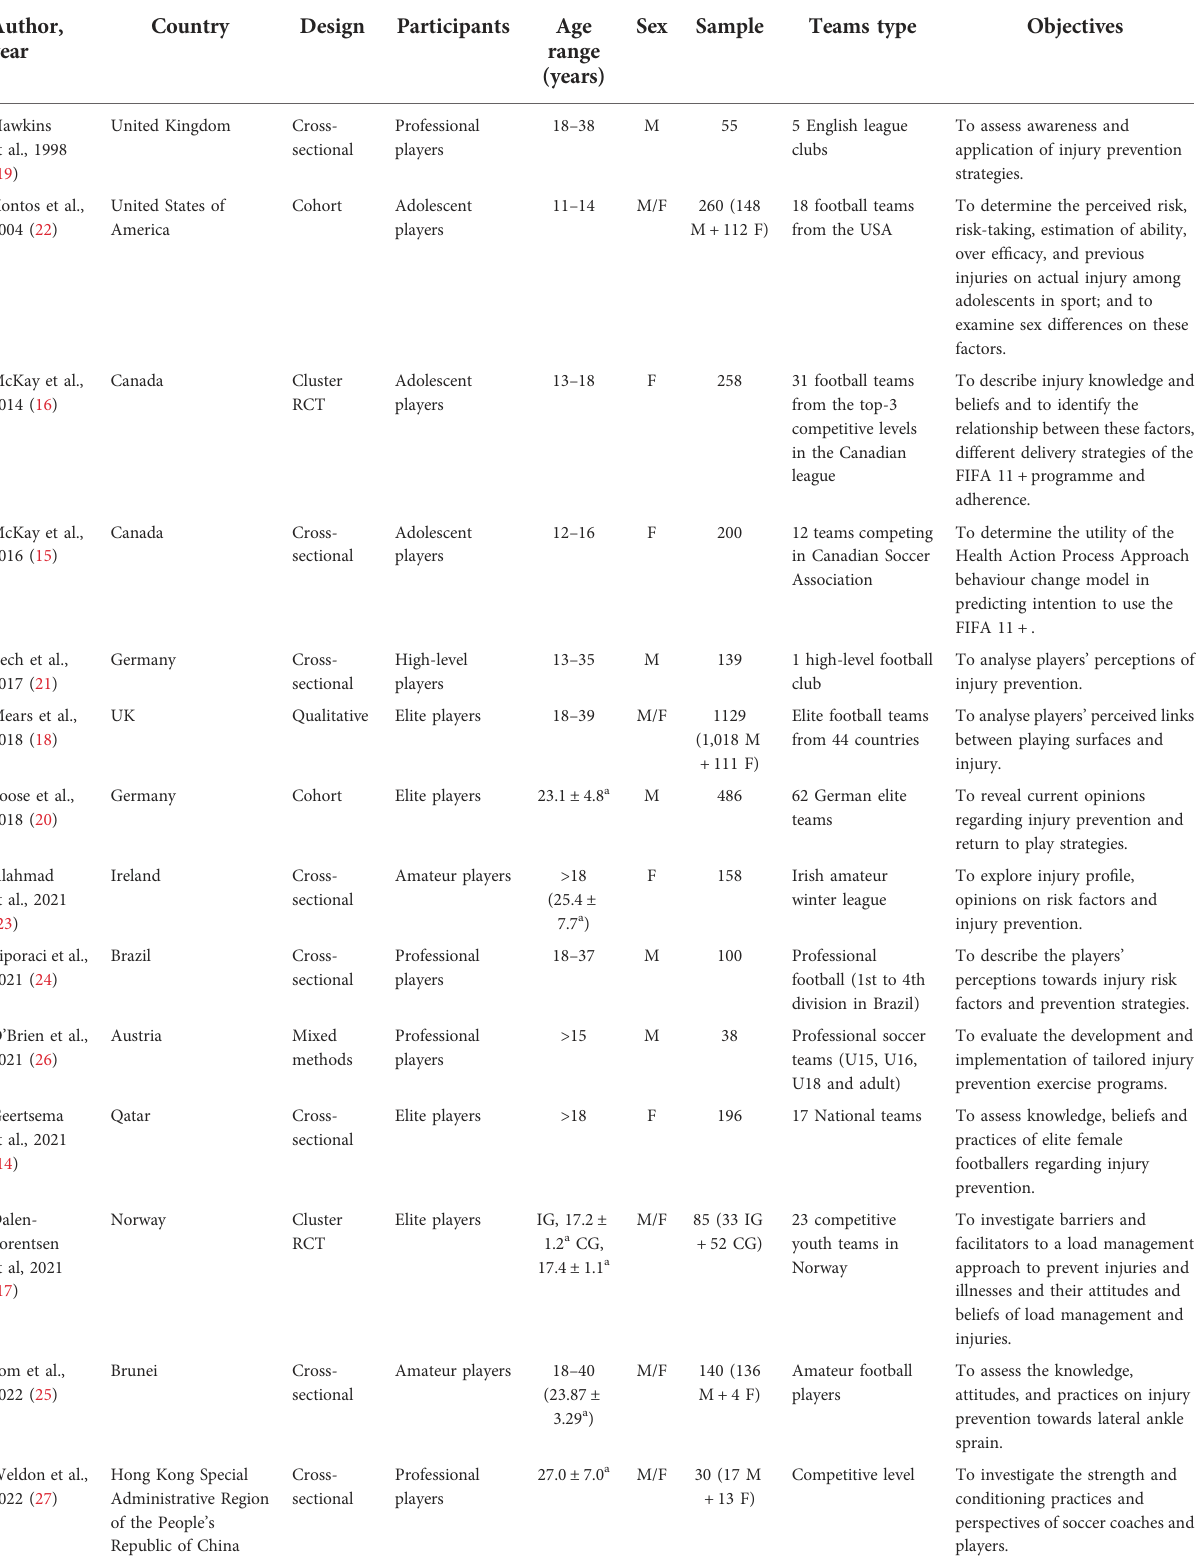
TABLE 1 Characteristics of included